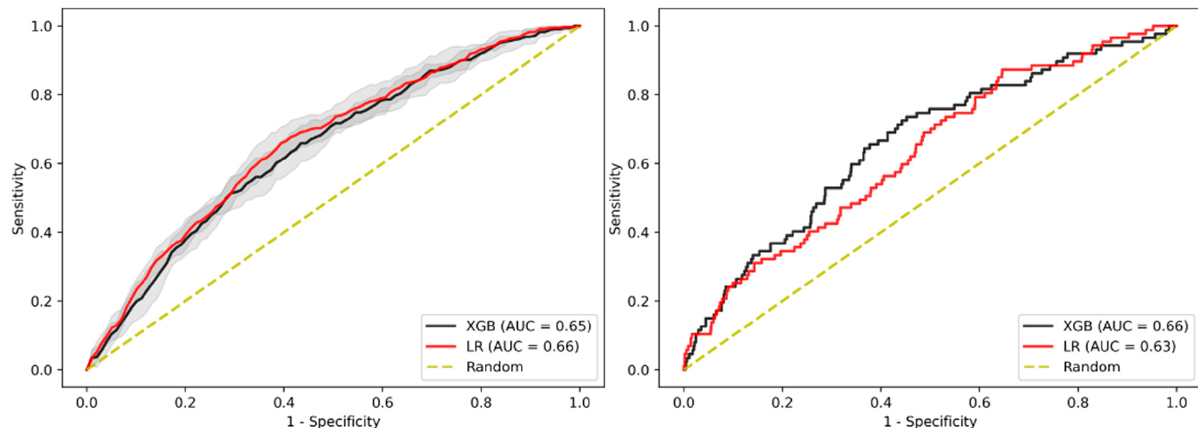
Figure 4. AUC-ROC performance of the XGBoost-based model and LR-based model to identify patients with AA when restricting cohort age range between (and including) 45 and 80 years. Internal validation cohort ( left ) and test cohort ( right ). Confidence intervals of 95% are shown in shaded grey.